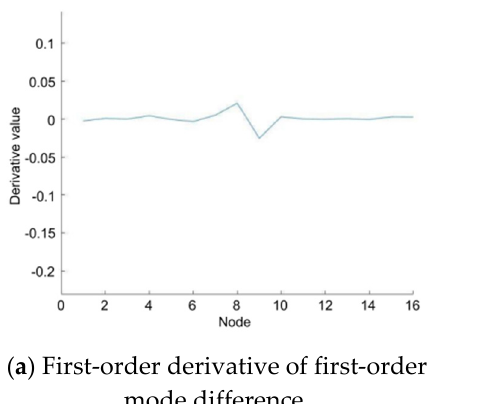
Figure 18. First-order and second-order derivative curves of the differences of the first five orders of modes under Conditions 5 and 6.